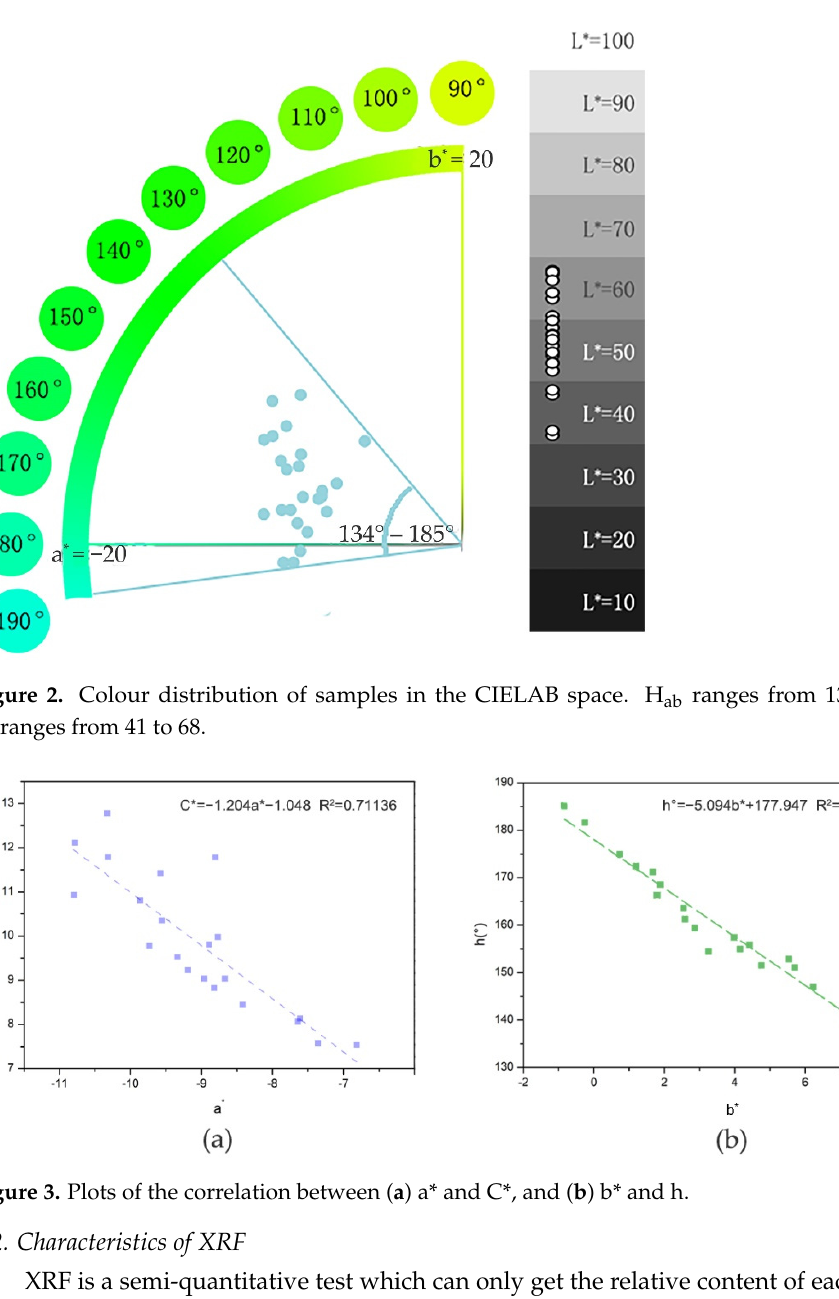
Figure 3. Plots of the correlation between ( a ) a* and C*, and ( b ) b* and h.